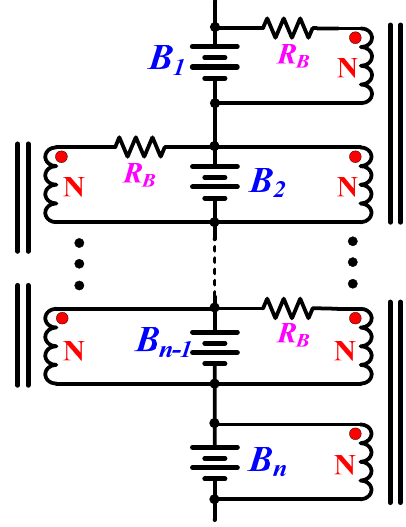
Figure 9. Model of the voltage equalizer in Figure 1a.